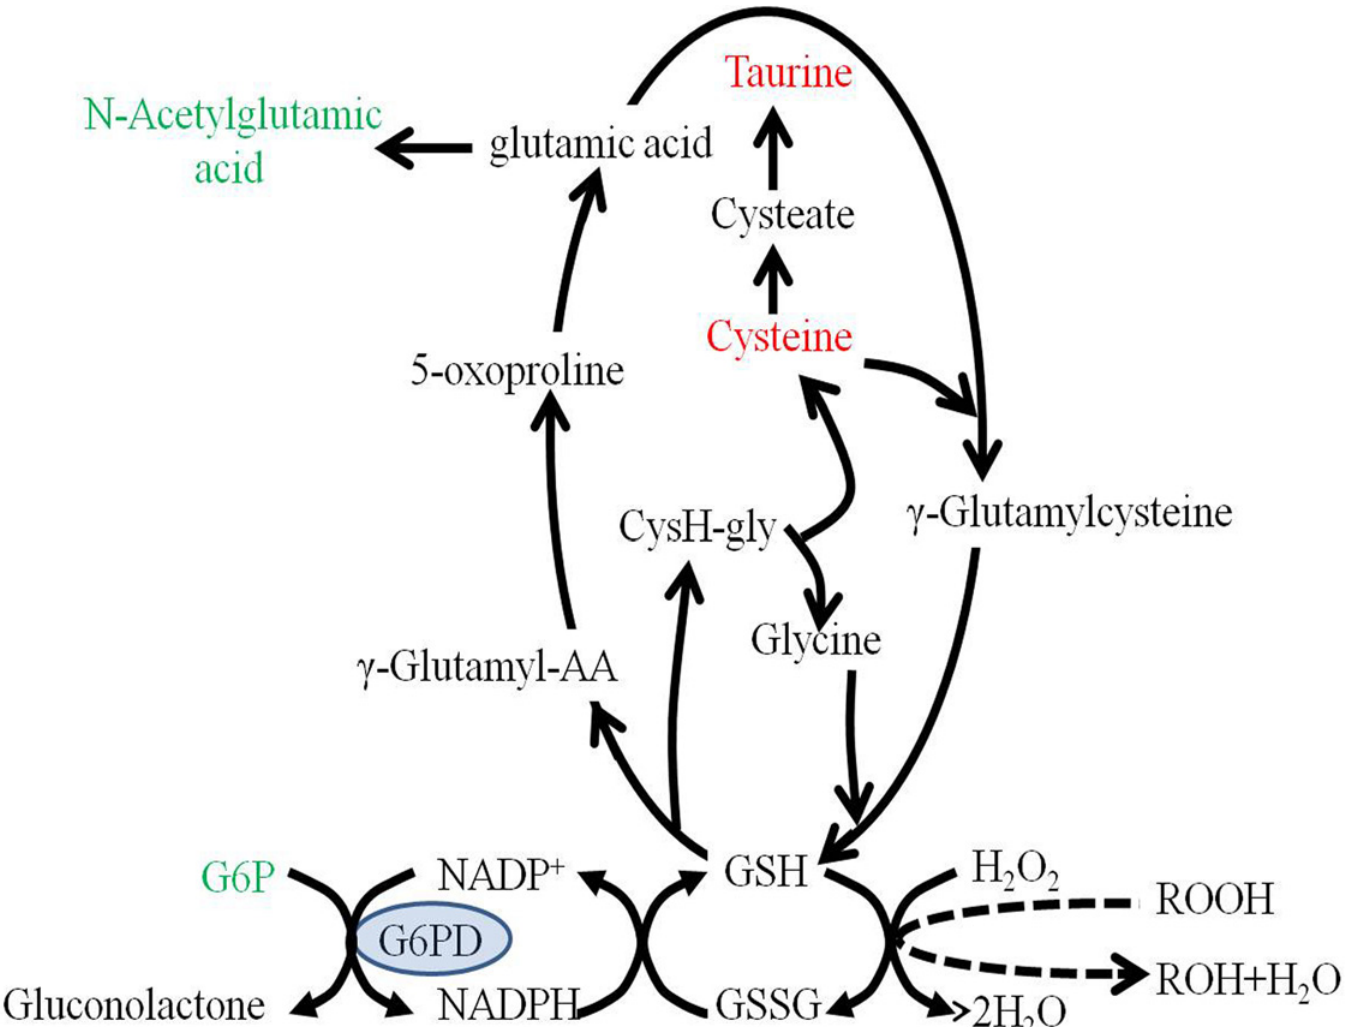
Fig 8. The alteration of cysteine and its relevant metabolic pathways according to the KEGG PATHWAY database. Putative metabolic pathways were inferred from changes in the intermediates levels in the liver of the G6PDx-FB mice. Red indicates the significantly elevated metabolites relative to those in the controls. Green shows significantly reduced metabolites relative to those in the